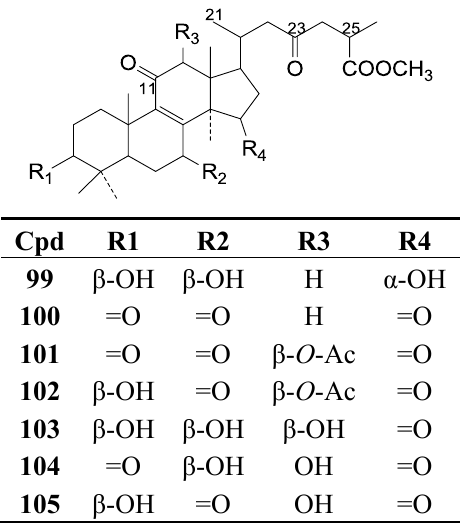
Figure 6. Structures of compounds 99 – 105 .